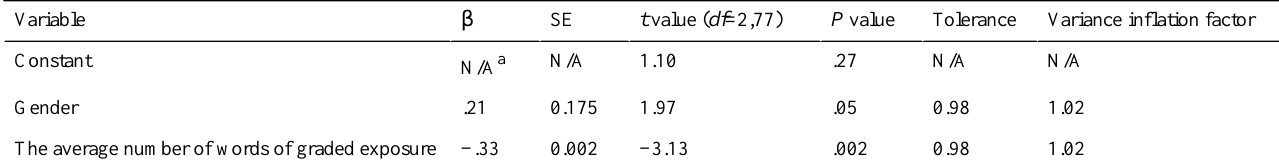
Table 2. The regression coefficients of the regression